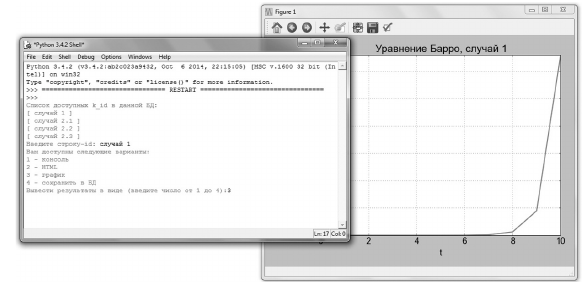
Fig. 7. Using the program in ”graph” output mode.